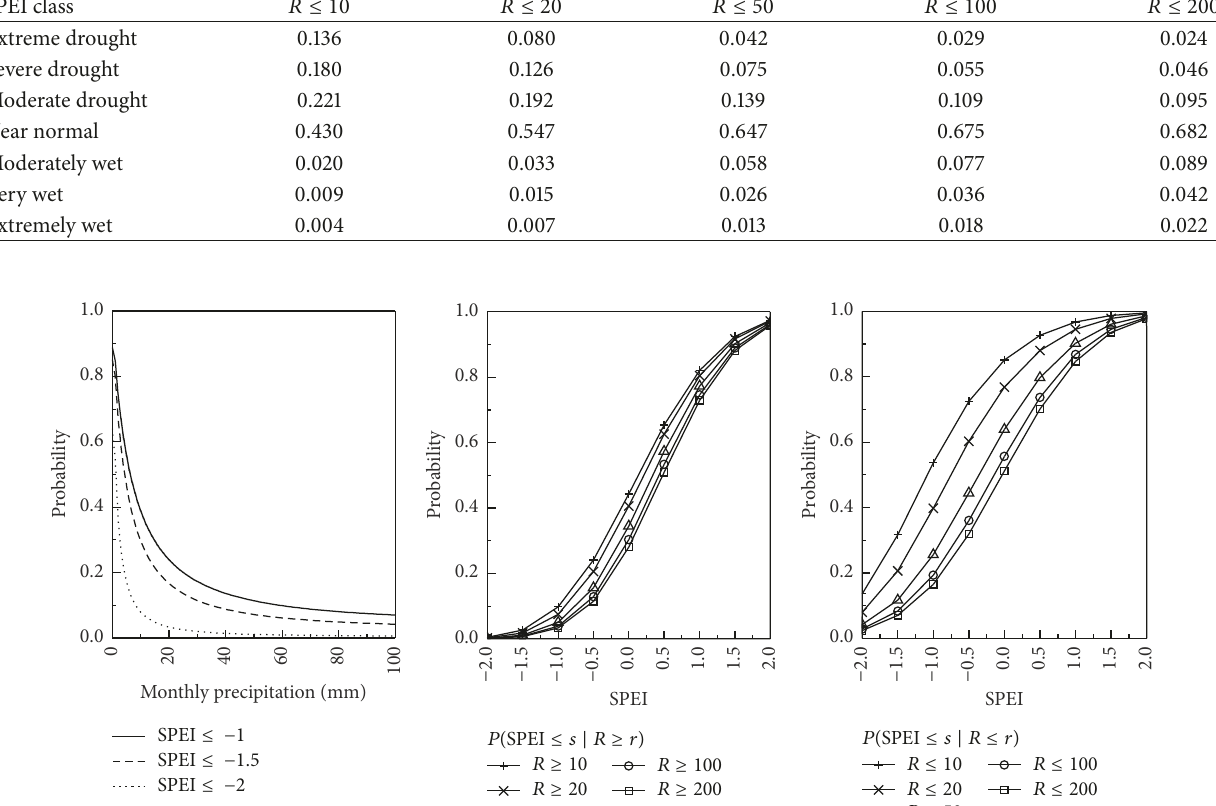
Table 4: Probabilities of SPEI classes when 𝑅 ≤ 𝑟 .